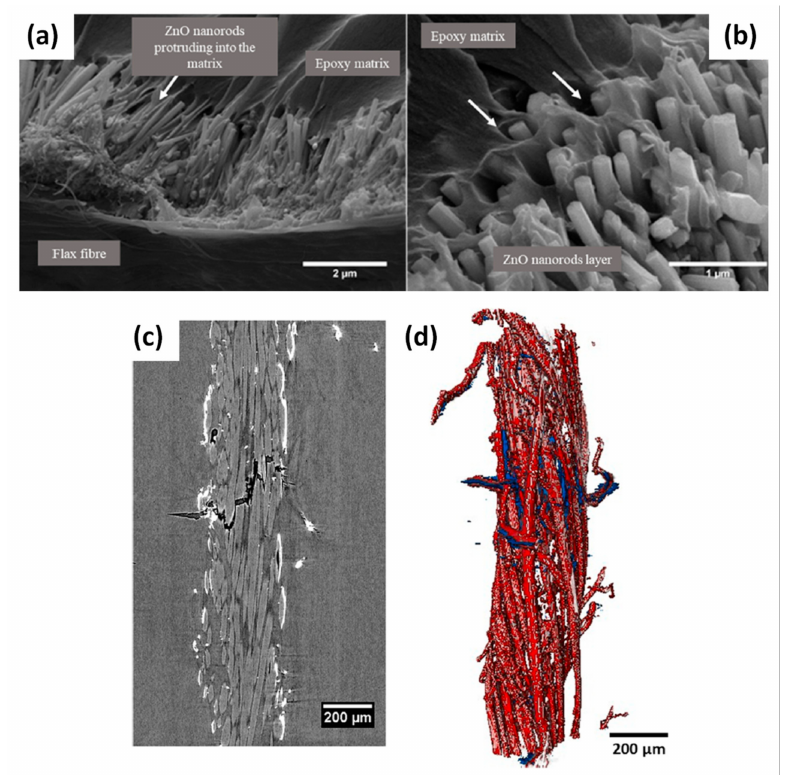
Figure 11. ( a , b ) FE-SEM micrographs showing fracture surfaces for ZnO-flax/epoxy single yarn composites. Micro-computed tomography observation for the ZnO-modified flax yarn/epoxy matrix with ( c ) high-resolution micro-CT image of the flax embedded in the epoxy resin and ( d ) volumetric reconstruction of the flax yarn and the fracture zone: the flax yarn is represented in dark grey, the fracture zone in blue and the ZnO coating in red (reprinted with permission from Sbardella et al., 2021